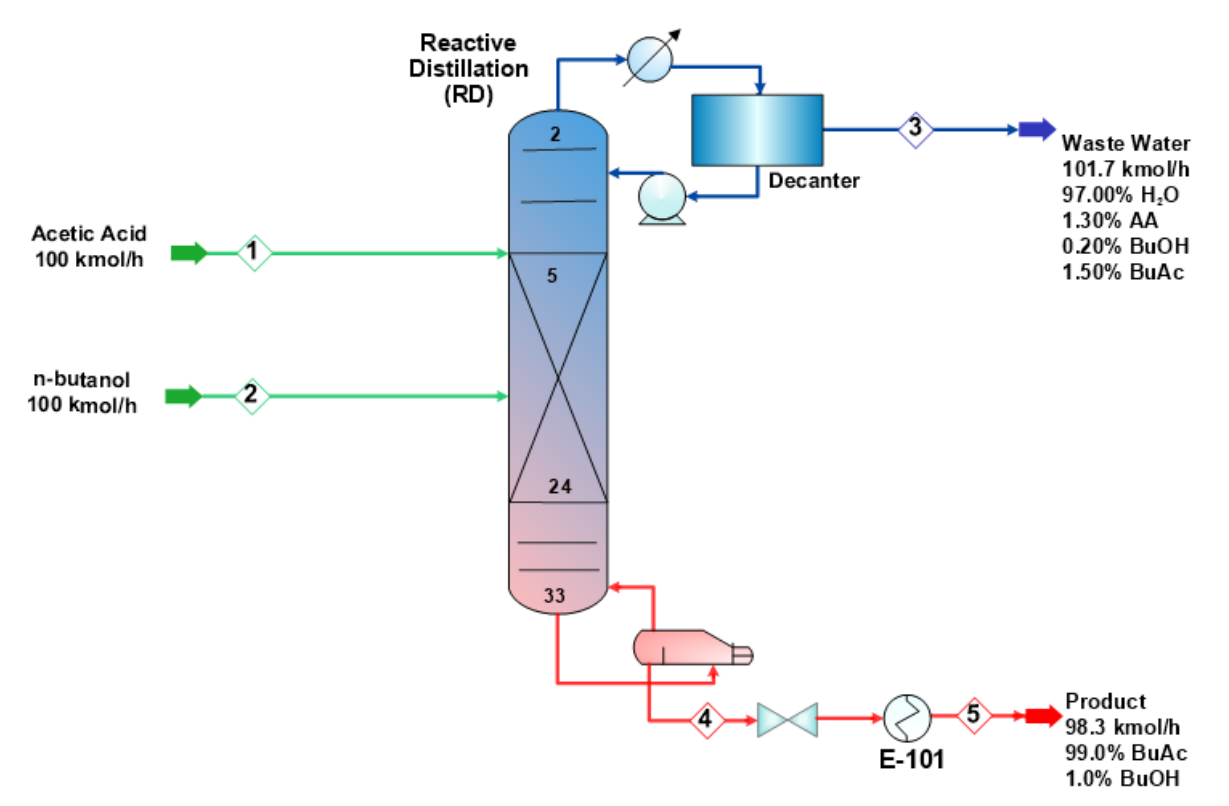
Figure 16. n -Butanol esterification with acetic acid by reactive distillation process. A decanter is used to separate the distillate into the water and organic phases. Wastew- ater of 101.6 kmol/h (stream 3) is sent to a wastewater treatment unit while the organic phase of the decanter is sent back to the column. The butyl acetate product is separated at the bottom of the RD with a purity of more than 99%. The product is sent to a cooler (E-101) and reduced to a temperature of 313 K. The stream information of the reactive-based process is shown in Table 9. The liquid-phase compositions and the temperature profile inside the reactive distillation column are shown in Figure 17a,b, respectively. Table 9. Stream information of the reactive distillation-based process for n -butanol esterification with acetic